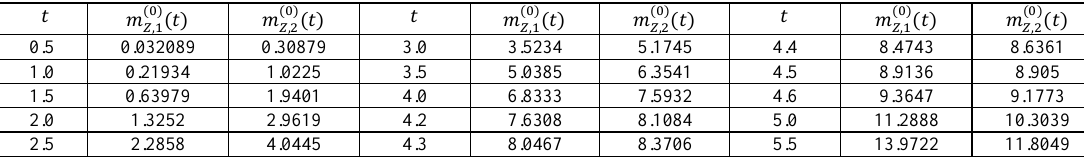
Table 3. Two mutation: comparison of growth of malignant